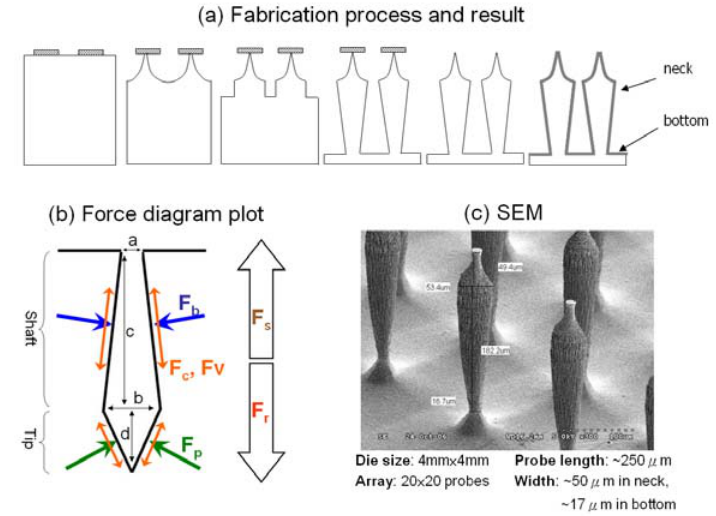
Figure 3. The modeling, fabrication and electrode-skin interface impedance measurement result of the